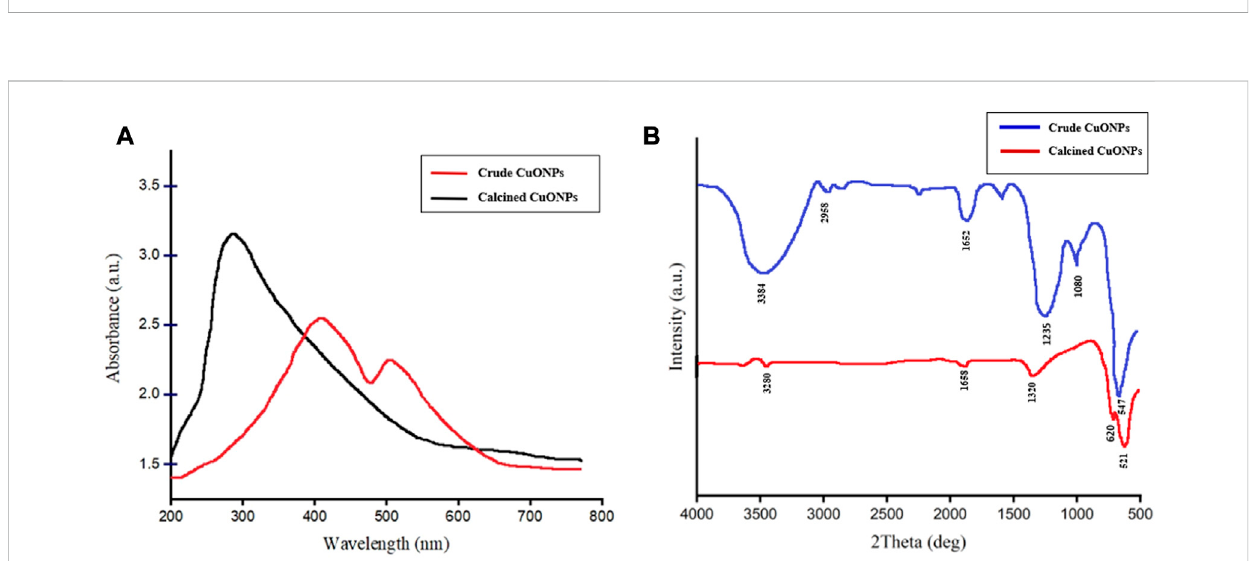
The UV-vis spectrum of crude and calcined CuONPs (A) ; maximum absorbance bands were observed at 286 nm and 420 nm, respectively, FTIR spectrum of crude and calcined CuONPs (B)